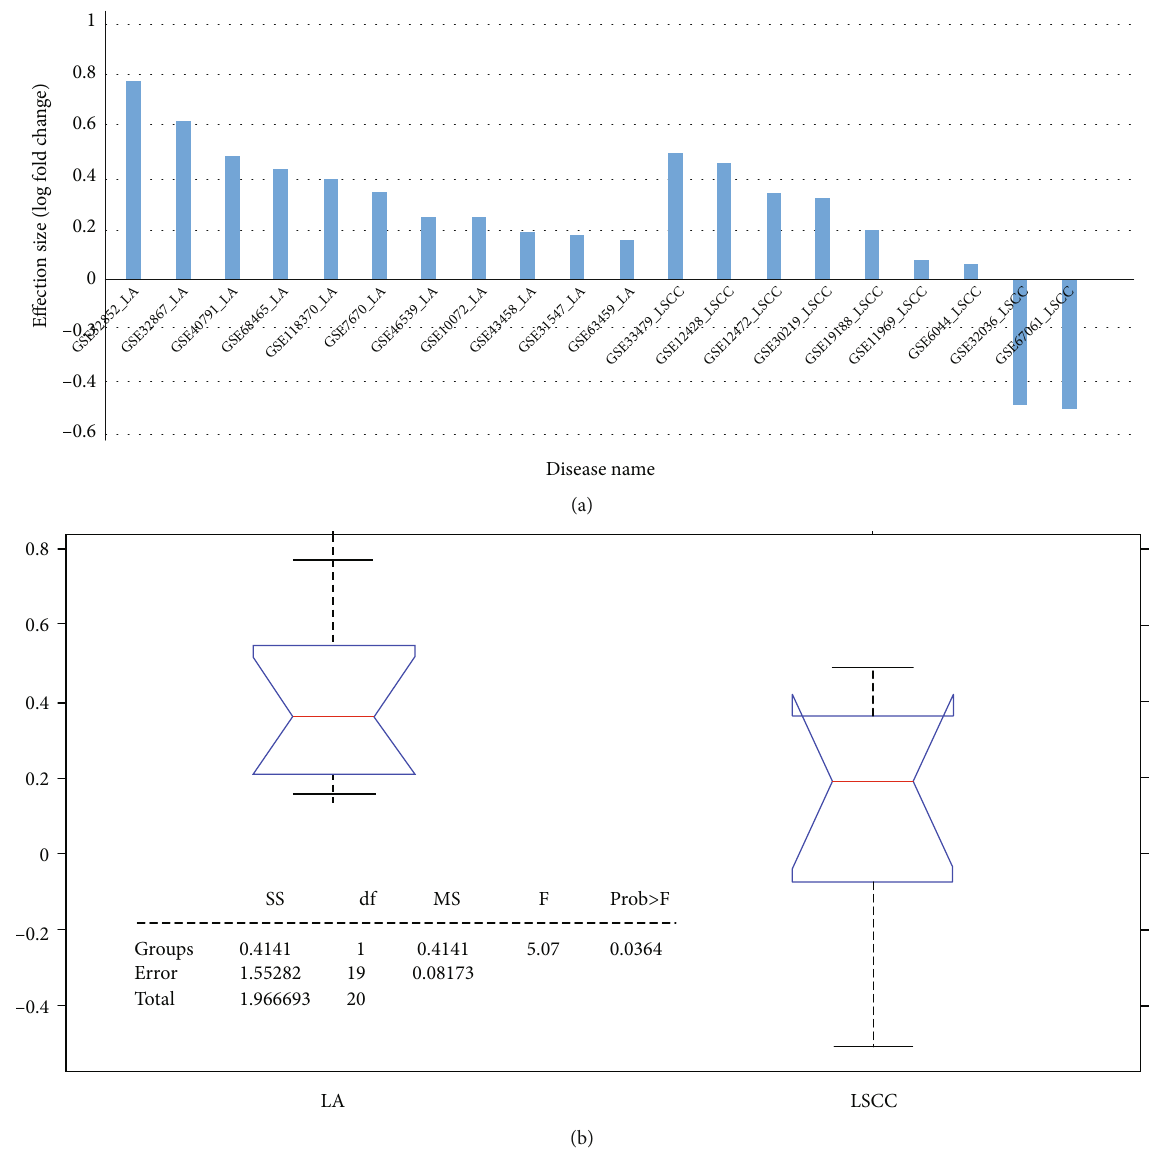
Figure 1: Expression of PPARD in 11 LA datasets and nine LSCC datasets: (a) bar plot of the expression log-fold change of PPARD; (b) boxplot of one-way ANOVA